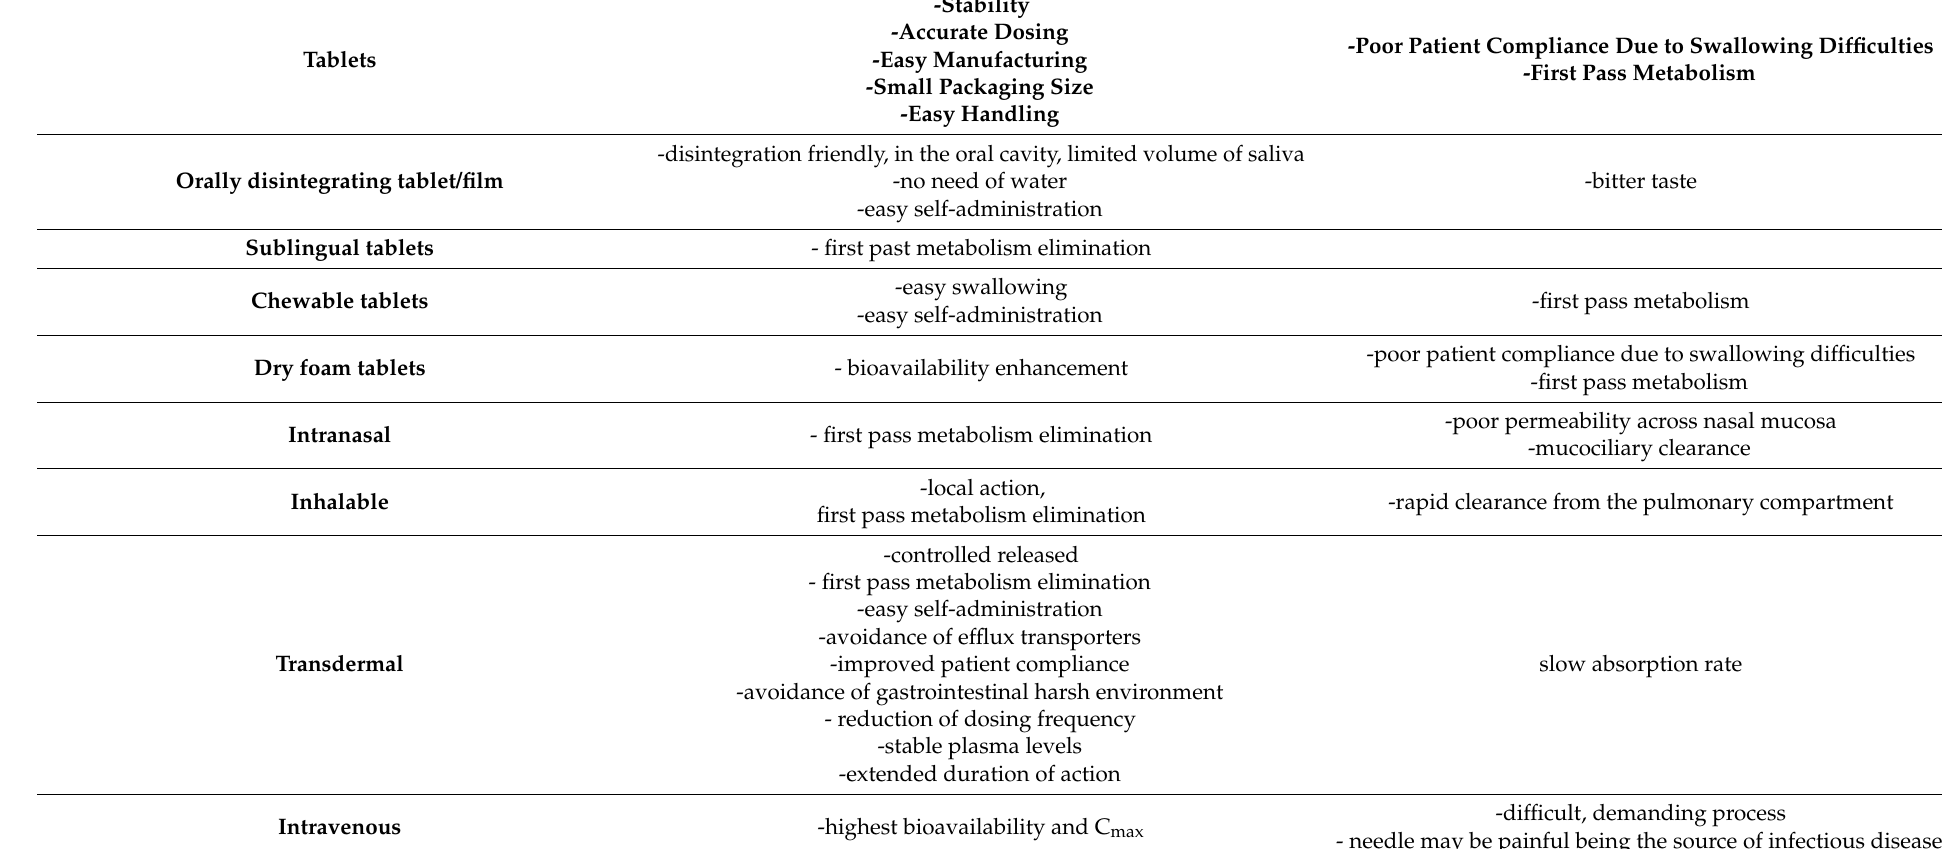
Table 2. Comprehensive collection of advantages and disadvantages of various studied